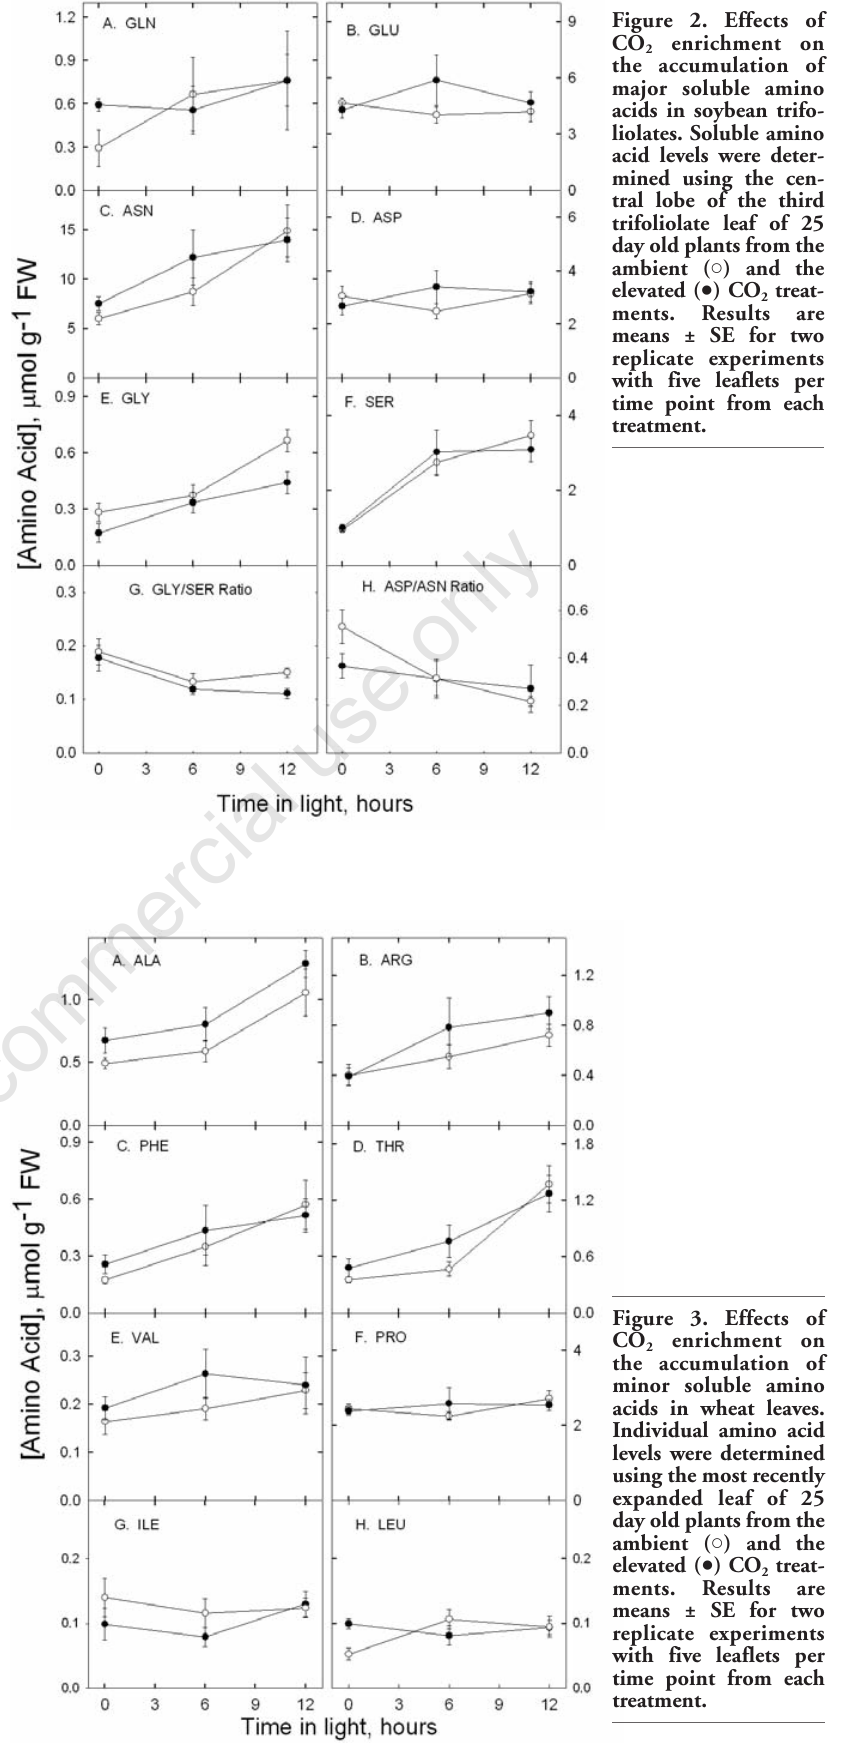
Figure 3. Effects of CO enrichment on 2 the accumulation of minor soluble amino acids in wheat leaves. Individual amino acid levels were determined using the most recently expanded leaf of 25 day old plants from the ambient ( ○ ) and the elevated ( ● ) CO treat- 2 ments. are means ± SE for two replicate experiments with five leaflets per time point from each